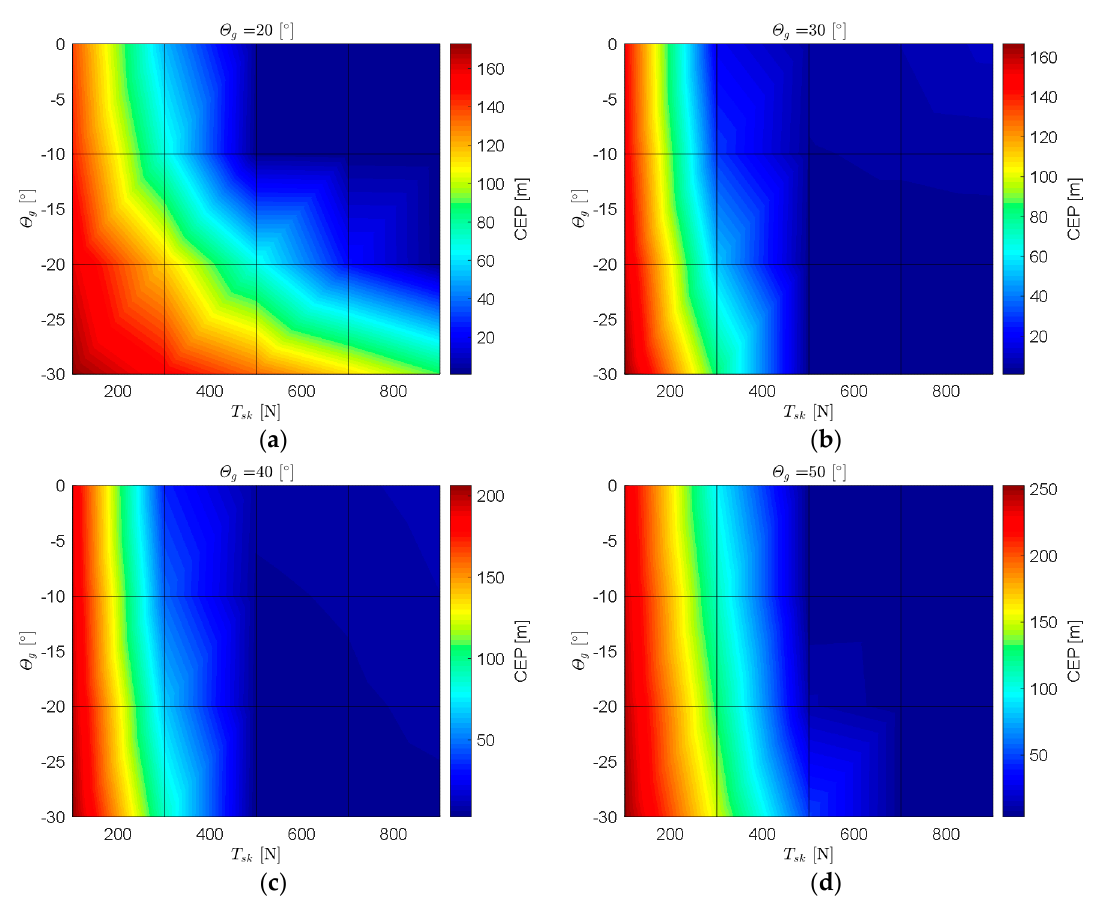
Figure 20. Circular error probable (CEP) for various lateral pulse magnitudes T sk and threshold pitch angles Θ g as a function of the initial elevation angle ( a ) Θ 0 = 20 ◦ ( b ) Θ 0 = 30 ◦ ( c ) Θ 0 = 40 ◦ ( d ) Θ 0 = 50 ◦ Figure 20 . Circular error probable (CEP) for various lateral pulse magnitudes 𝑇 (cid:3046)(cid:3038) and threshold pitch angles 𝛩 (cid:3034) as a function of the initial elevation angle (a) 𝛩 (cid:2868) = 20° (b) 𝛩 (cid:2868) = 30° (c) 𝛩 (cid:2868) = 40° (d) 𝛩 (cid:2868) = 50°. CEP varies significantly for various combinations of 𝑇 (cid:3046)(cid:3038) and 𝛩 (cid:3034) . The greatest dispersion